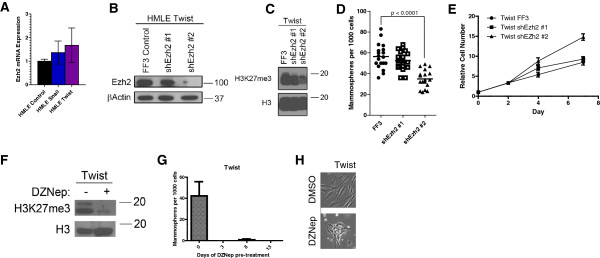
EZH2 is required for Twist-induced stemness. (A) Quantitative reverse transcription polymerase chain reaction expression of EZH2 in human mammary epithelial (HMLE) cells expressing the indicated epithelial-mesenchymal transition (EMT) inducers. (B) EZH2 protein levels assessed by western blot in HMLE Twist cells transduced by vectors expressing two different short hairpin RNAs (shRNAs) targeting EZH2 and a control vector (FF3). Note that ShRNA #2 was more efficient in reducing EZH2 protein levels as indicated by western blot. (C) Histone H3 and H3K27me3 protein levels assessed by western blot indicate that shRNA #2 reduces H3K27me3. (D) Mammospheres were counted in HMLE Twist FF3 cells (control) and shEZH2 cells grown in mammosphere-promoting conditions. Spheres greater in size than 50 micrometers after 10 days were counted and a Student’s t-test was performed. (E) Count of HMLE Twist FF3 (control) and shEZH2 cells after multiple days in standard cell culture conditions. (F) Western blot analysis of H3K27me3 level in HMLE Twist cells before and after treatment with 3-deazaneplanocin A. (G) HMLE Twist cells were treated with 2.5 μM of 3-deazaneplanocin A for 8 days followed by 48 hours without drug. Surviving cells were then subjected to a sphere assay in the absence of drug for 8 days. (H) The morphology of HMLE Twist cells treated with 2.5 μM 3-deazaneplanocin A is depicted after 8 days of treatment. We observed a change toward an epithelial morphology.